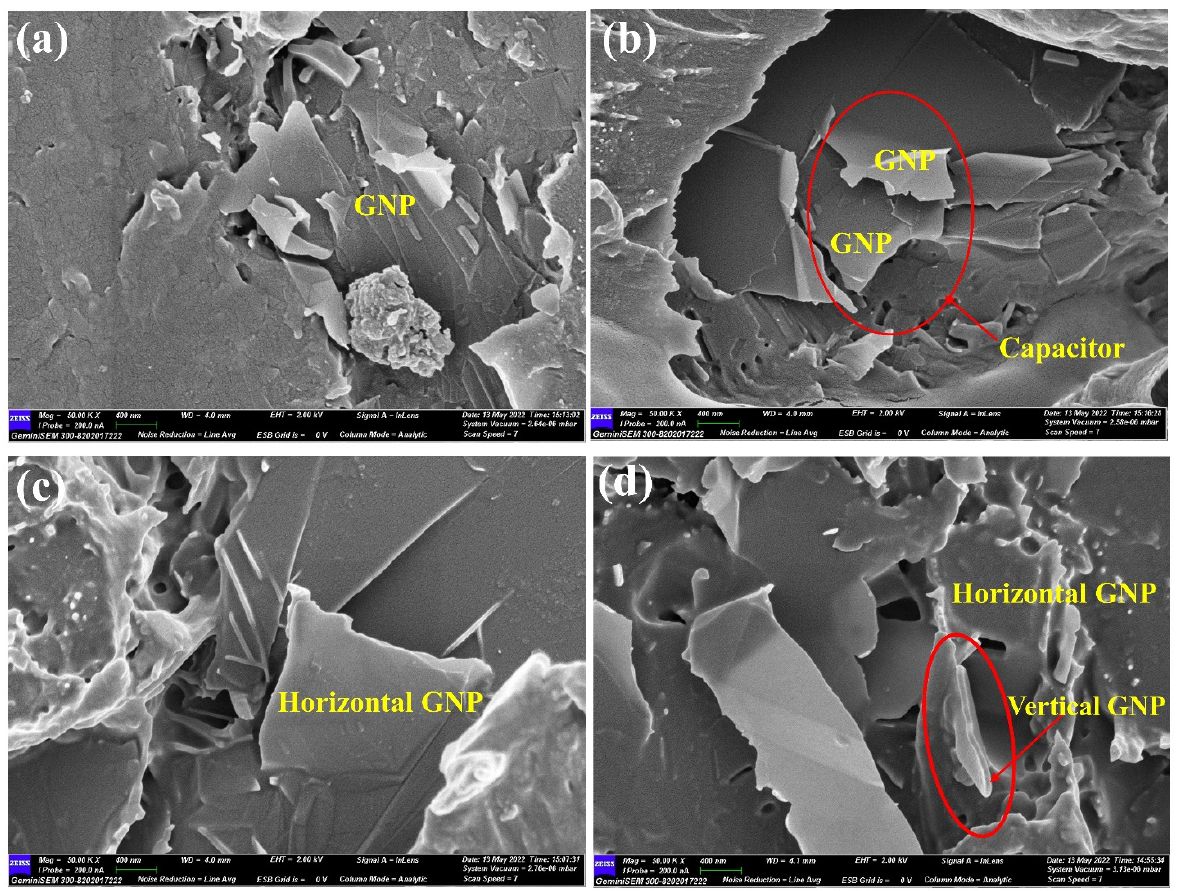
Figure 10. The SEM images of polymer nanocomposite films ( a ) ABS+GNP6, ( b ) ABS+GNP9, ( c ) ABS+GNP12, ( d ) ABS+GNP15.